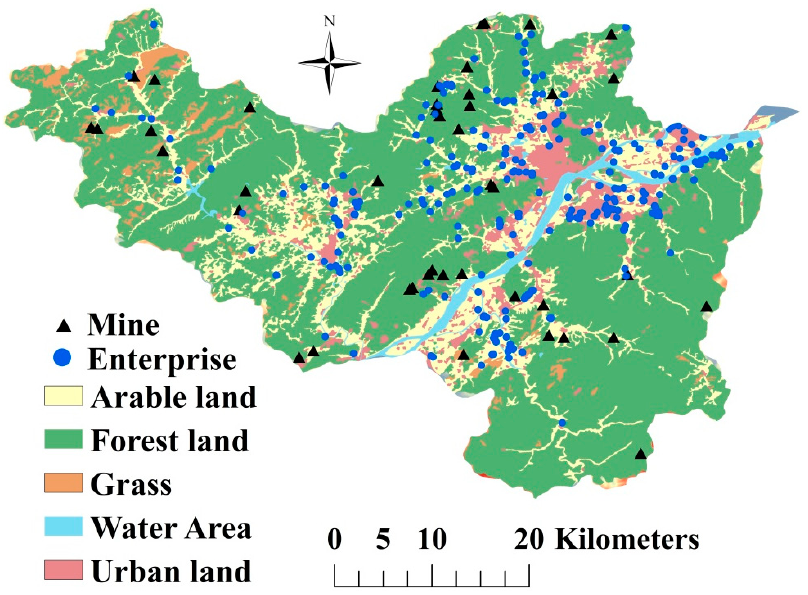
Figure 5. Land use map of Fuyang.